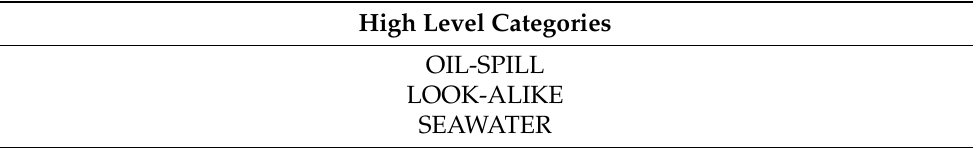
Table 3. Oil-spill high level